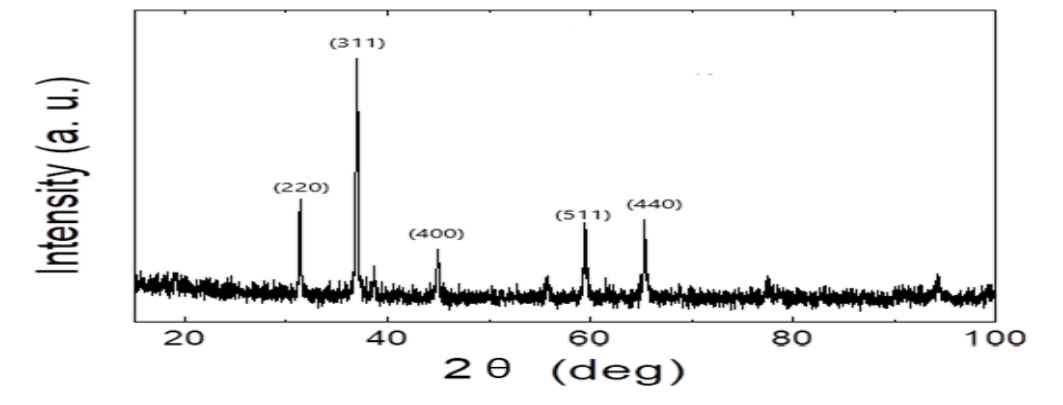
Fig.1: X-ray diffraction (XRD) pattern of CoO